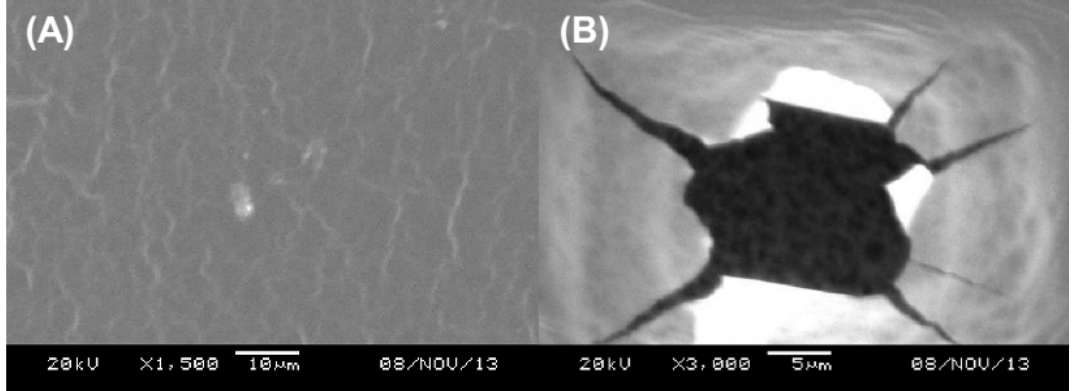
Figure 5. Scanning electron microscope image of PVA–AmB hydrogel evidencing the sample deformation, caused by the electron beam, as the magnification increment goes from 1500× ( A ) to 3000× ( B ).